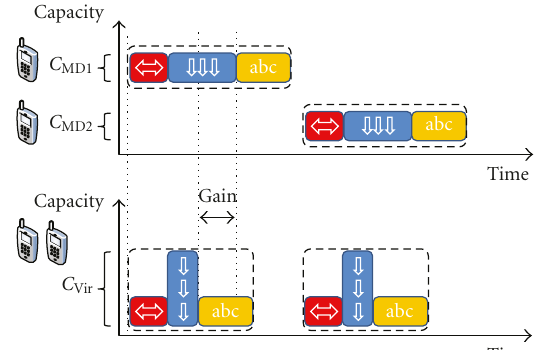
Figure 3: The figure shows the values of C Vir in the cooperative as well as noncooperative case without overlapping of the download phases.